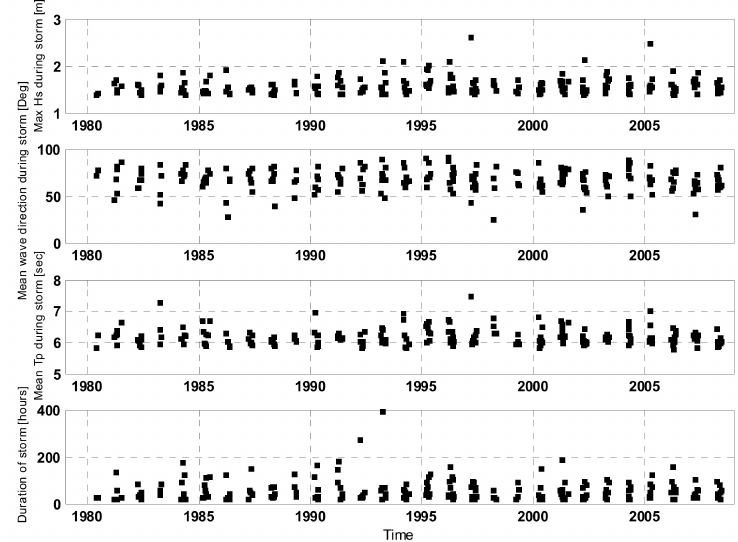
Figure 8. Storms characteristics at Dutch Bay, Trincomalee (Cell T-VIII).